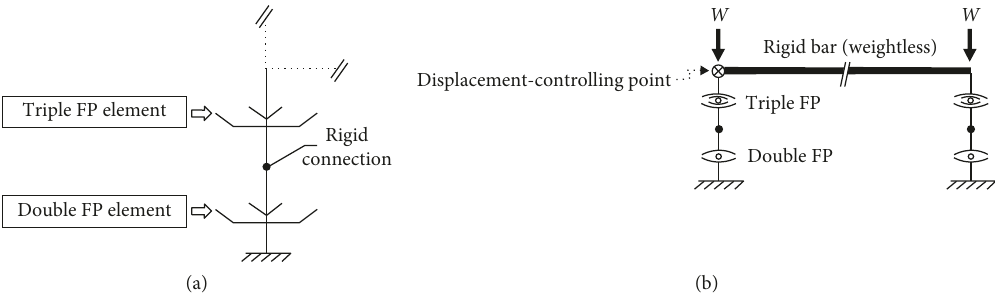
Figure 3: (a) Series model of QFPB with a pair of double and triple FP elements and (b) model equipped with QFPBs as implemented in SAP2000 (adopted from